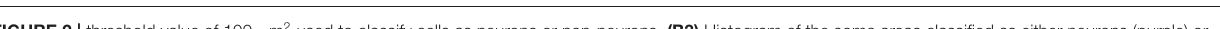
FIGURE 2 | threshold value of 100 µ m 2 used to classify cells as neurons or non-neurons. (B3) Histogram of the soma areas classified as either neurons (purple) or non-neurons (black). (C,D) Example confocal images and cell type identification for two of the 10 constructs tested. Top shows the GFP image channels, obtained from IO injected with AAV9-Htr5b(3.7) and AAV9-CAG ( C and D , respectively), and middle show tdTomato channel confocal scan, reporting for the reference construct (AAV-PHP.S-CAG) expression. Both images are maximal z -projections of a 30 µ m thick stack volume. Right (C3,D3) show histograms for labeled soma sizes obtained for the two example constructs (red and green histograms), as well as those for the control constructs (gray histograms). Dashed vertical line denotes the 100 µ m 2 soma area threshold used to classify cells as either neurons or astrocytes. Note that the color scales in each confocal image are adjusted for visual clarity, and quantitative assessments are done based on the numerical comparisons as shown in other. (E) Summary of the cell-type preference of the 10 constructs, where expression in neurons is normalized to expression in non-neurons in the same slices. The ratio was calculated per-animal on ∼ 80 astrocytes and 80 neurons per animal. Each dot is the average of neuron-to-astrocyte ratio per animal and the value is an indicator for neuronal expression performance in IO. The statistics compare cell-type-preference of the test virus to the reference virus (AAV.PHP.S-CAG-tdTomato) in material where both vectors are co-expressing tdTomato and EGFP transgenes. The only construct with clear preference for IO neurons was the AAV9-Htr5b(3.7) (Welch t-test, t = 2.93, p = 0.026). (F) Summary of the normalized expression strength in neuronal cells among the 10 constructs (76 to 88 neurons were selected in each construct using the 100 µ m 2 surface threshold). Neuronal expression of test transgene was normalized to the expression of reference transgene (AAV.PHP.S-CAG-tdTomato) for each neuron, then the population was averaged. Statistics compare the normalized expression of high-expression test vectors to the normalized expression AAV-CAG-EGFP transgene. The constructs to the right of the dashed vertical line are expressed stronger in neurons than the reference construct. The difference of expression between test transgene and control transgene in neurons co-expressing both proteins is stronger in AAV9-Htr5b(3.7) compared to AAV9-CAG (Welch t -test, t = -6.09, p < 0.001). EGFP is